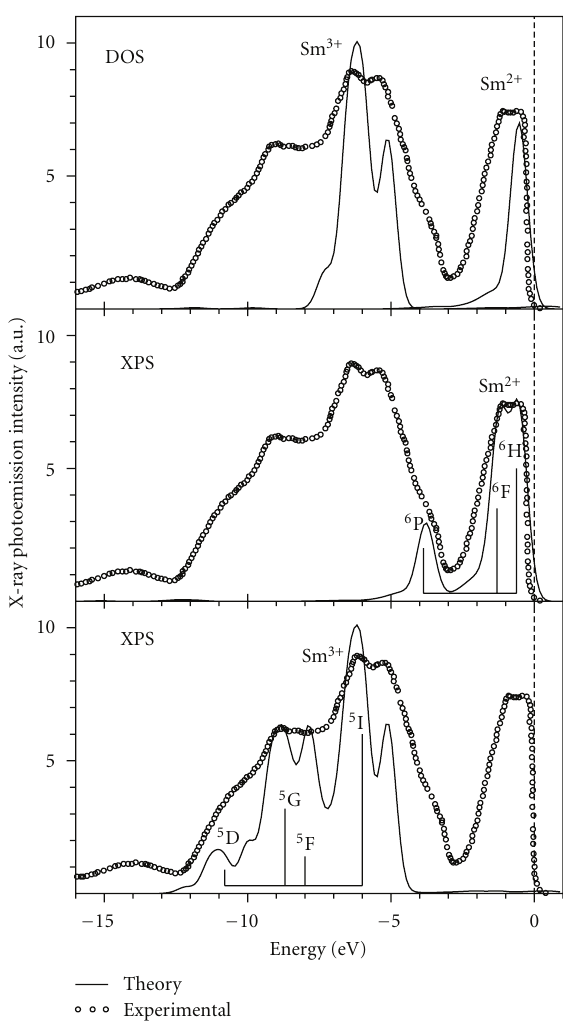
Figure 89: Comparison of the calculated 4 f DOS of Sm 3 S 4 in the LSDA+ U approximations with the experimental XPS spectrum from [5] taking into account the multiplet structure of the 4 f 5 final state (see explanations in the text)